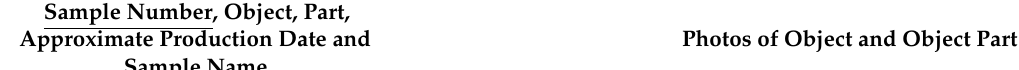
Table 11. Blooming samples. B(c): Blooming (crystalline), B(o): Blooming (other). The internal survey numbers for samples are used here as the ‘sample number’ for orientation throughout the text. Photos: Till Krieg, except gas mask: Florian Pohlmann.